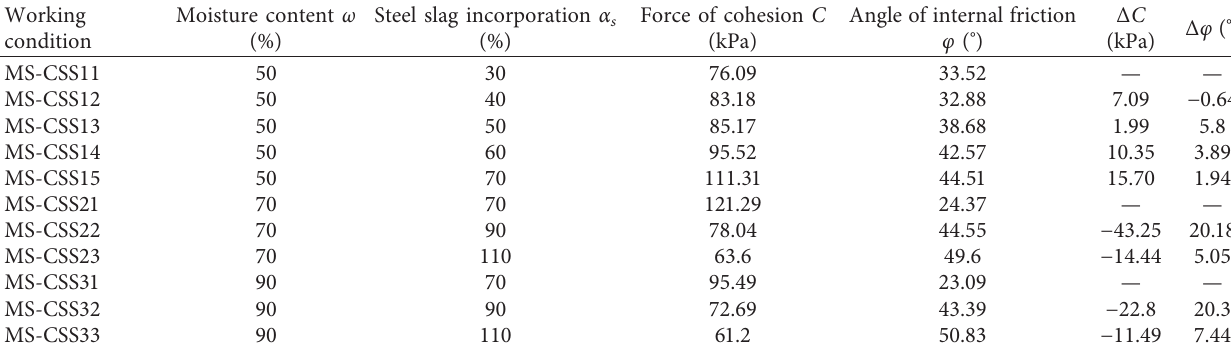
Table 6: Cohesion and internal friction angle of mixture soil.